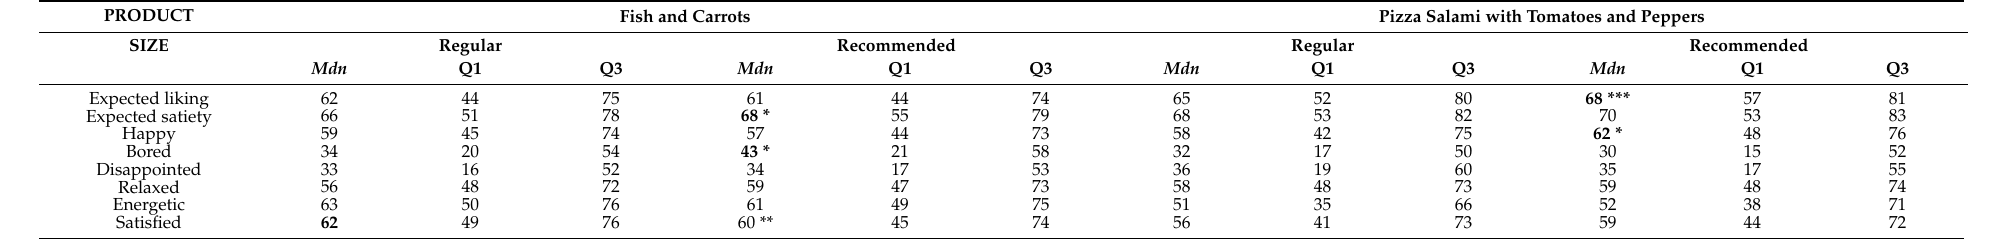
Table 3. Medians and interquartile ranges of the intensities of the expected liking, expected satiety, and expected food-evoked emotions for regular and recommended portion sizes per